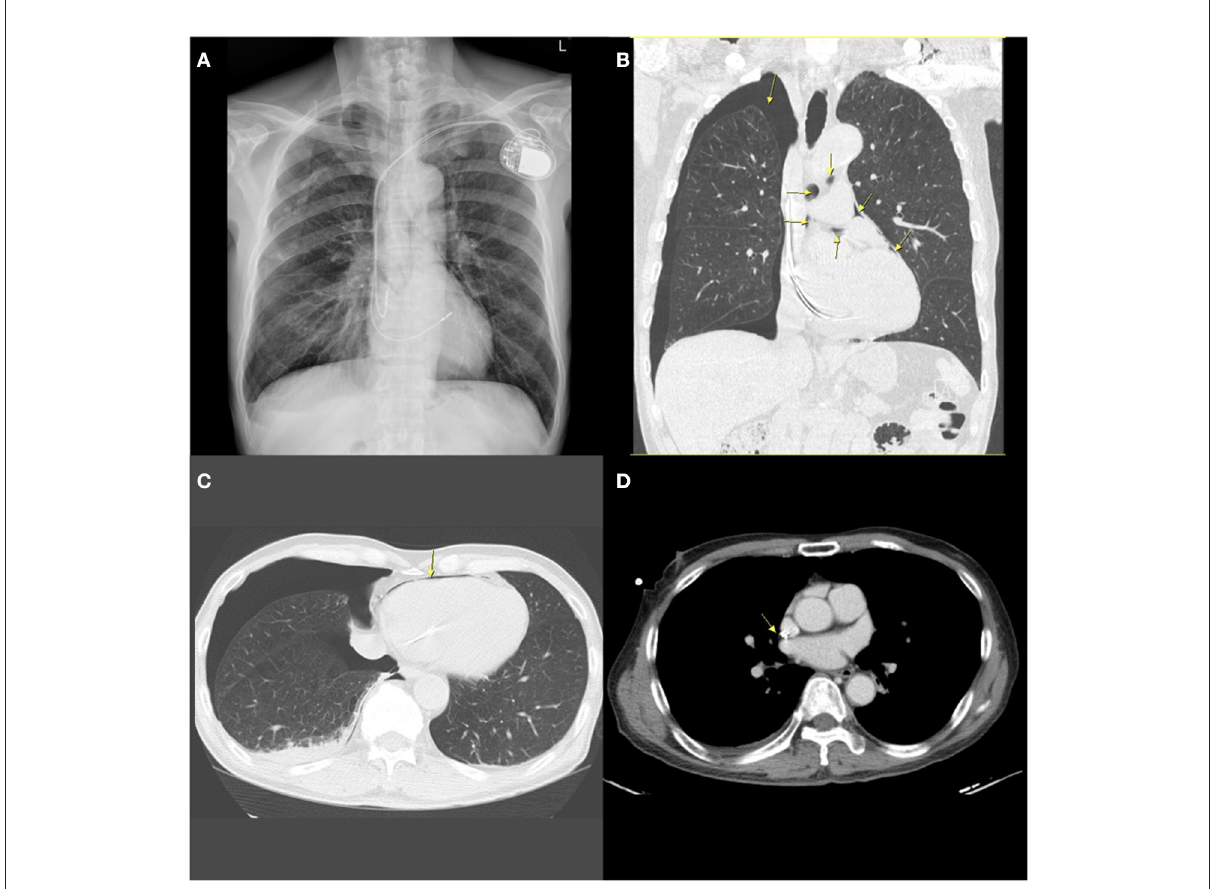
FIGURE1 A chest radiograph performed 5h after implantation showing contralateral pneumothorax, pneumopericardium, and pneumomediastinum. (A) Posterior-anterior (PA) chest X-ray demonstrating contralateral pneumothorax and mild pneumomediastinum. (B) Coronal chest non-contrast computed tomography (CT) scan image showing right-sided pneumothorax, pneumomediastinum, and pneumopericardium (arrows). (C) Horizontal CT image showing pneumopericardium (arrow) and pneumothorax. (D) Horizontal slices of CT scan suggesting possible extrusion of the atrial lead through the right atrium